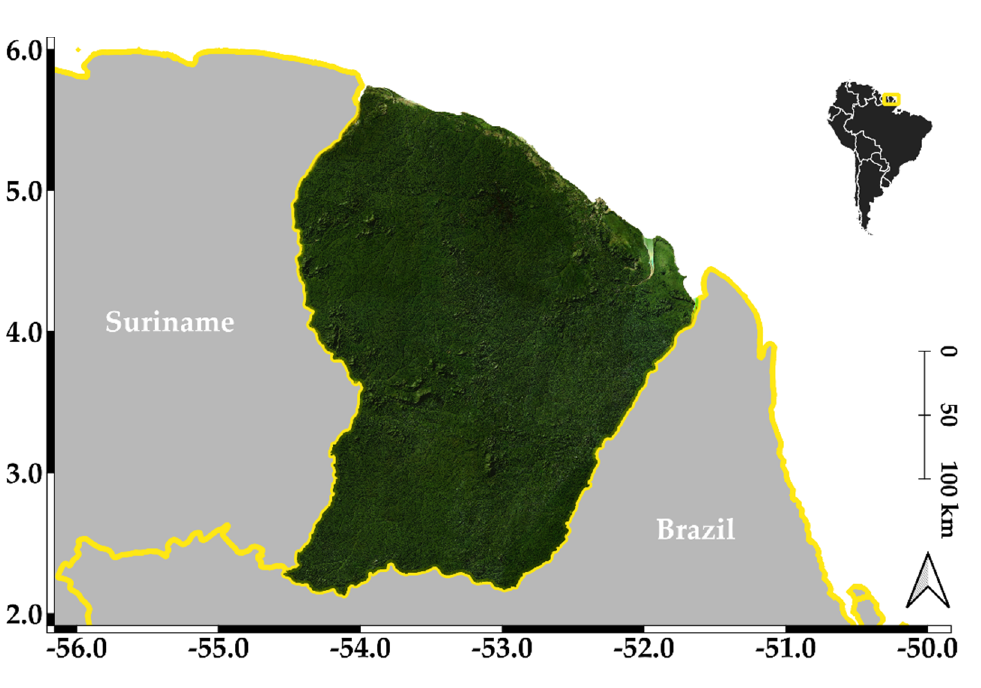
Figure 1. Location of the study site.